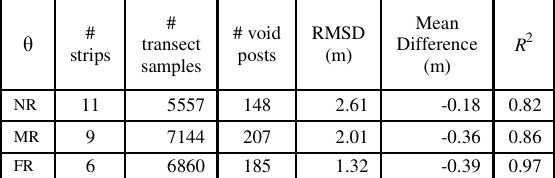
Table 4. Comparison of h spc for 19,561 sample points located along transect lines of slopes <10 ° in the NR ( θ =35 ° ), MR ( θ =45 ° ), and FR ( θ =55 ° ), for single-pass X-HH InSAR (single- data takes) compared to NEXTMap X-HH InSAR (multi-pass) for all data combined, and averaged based on samples per site. Given the difference in site characteristics, analysis were conducted per site (Tables 5-7), to determine if similar results prevailed.